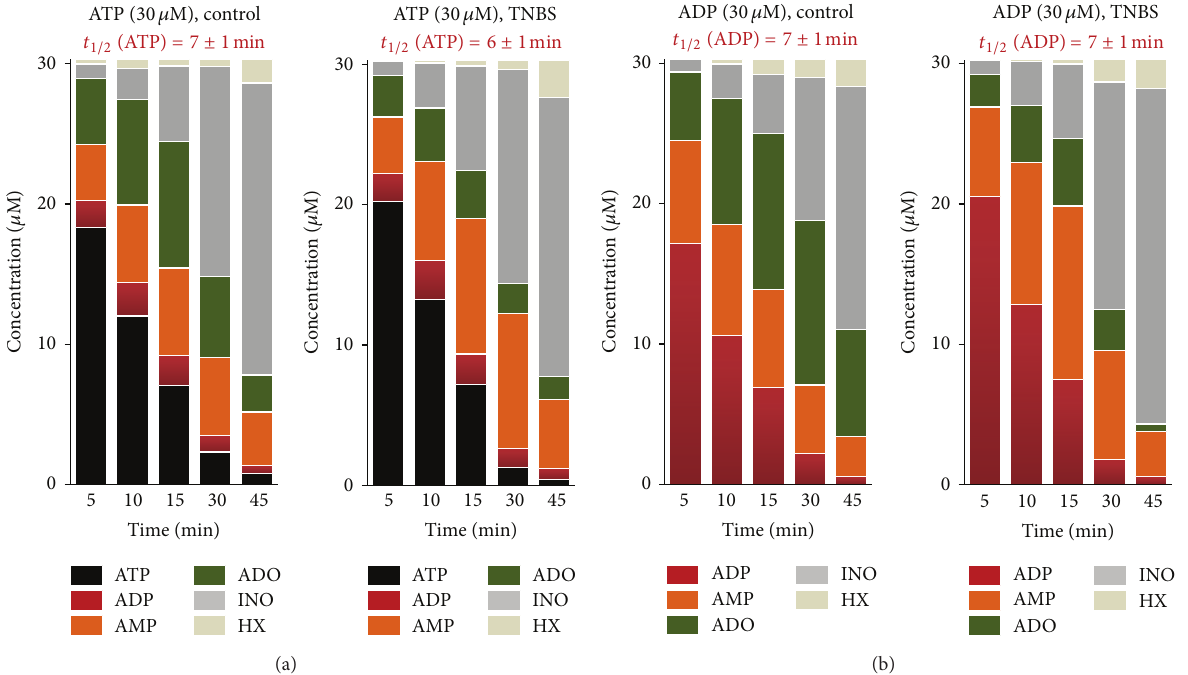
Figure 5: Kinetics of the extracellular catabolism of ATP (a) and ADP (b) in the LM-MP of the ileum of control and TNBS-injected rats. ATP and ADP (30 𝜇 M) were incubated at zero time (see Section 2). Collected samples were analysed by HPLC with UV detection to separate and quantify ATP (black), ADP (red), AMP (orange), ADO (green), INO (dark grey), and HX (light grey). Average results obtained in four